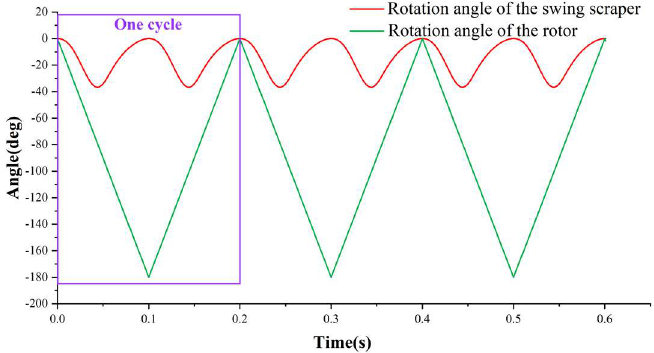
Figure 8. Comparison of the rotation angles.